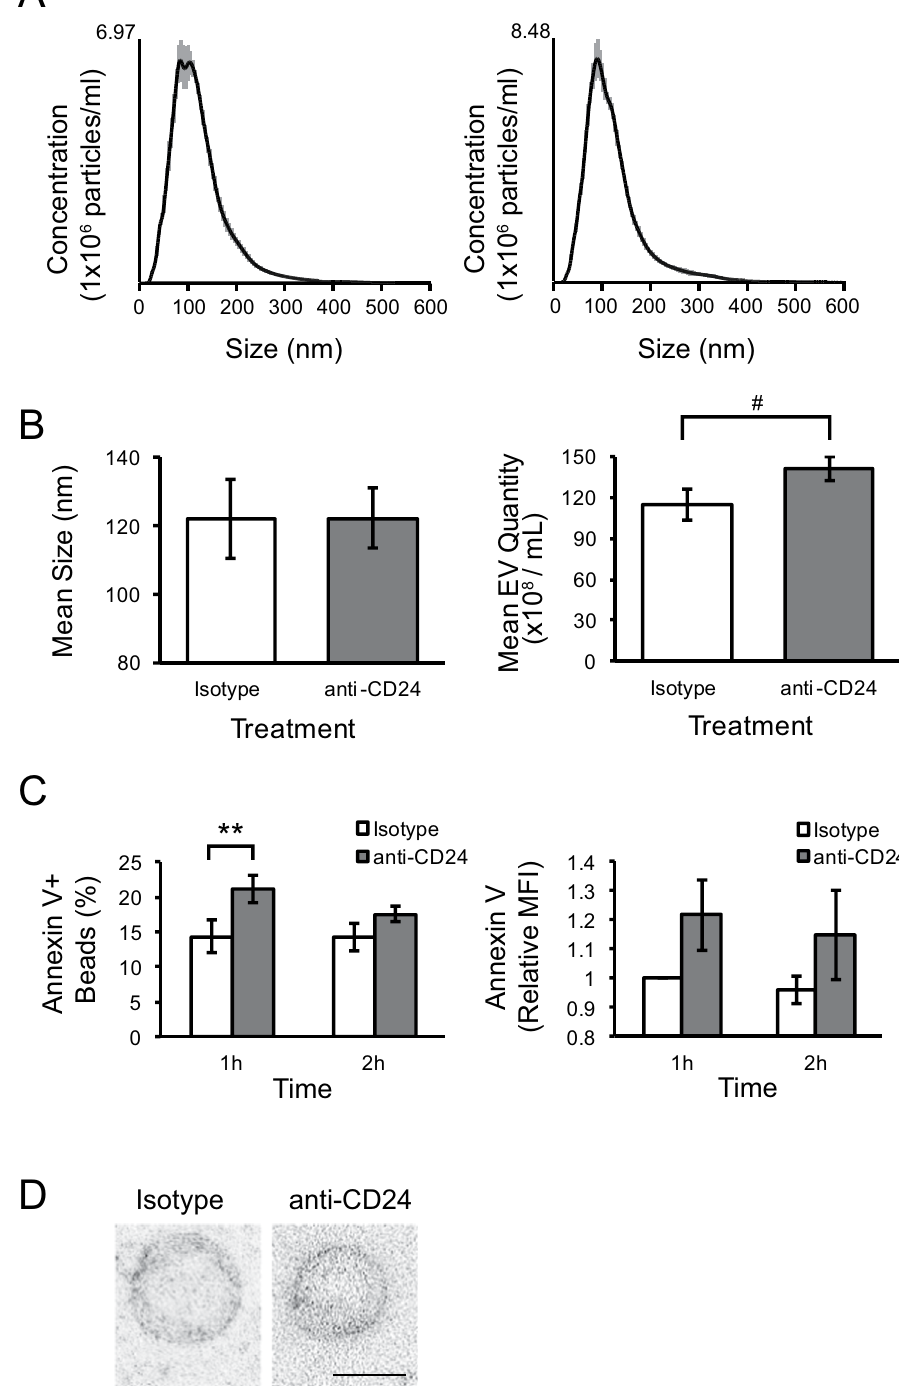
Figure 1. The quantification and morphology of MVs released from B cells with and without CD24 stimulation. ( A ) Representative nanoparticle tracking (NTA) plots of particle sizes and concentrations in supernatants from cells stimulated with either isotype (right) or anti-CD24 (left) Ab after 1 h. Grey lines show ± 1 standard deviation of the mean in measurements. n = 3 biological replicates with 5 technical replicates each. ( B ) The mean size (left) and concentration (right) ± SEM of particles from supernatants analyzed by NTA, n = 3. Statistical significance was assessed using Students’ paired t-test, # p = 0.08. ( C ) Mean % positive (left) and relative mean fluorescent intensity (MFI; right) of Annexin V-FITC beads used to capture CD24-bearing MVs released from isotype or anti-CD24 stimulated cells for the indicated times, n = 3. Statistics assessed by a two- tailed Student’s paired t-test. ** p < 0.01. ( D ) Representative transmission electron microscopy (TEM) images of Vn96-isolated EVs from cells stimulated with either isotype or anti-CD24 for 1 h. Scale bar = 100